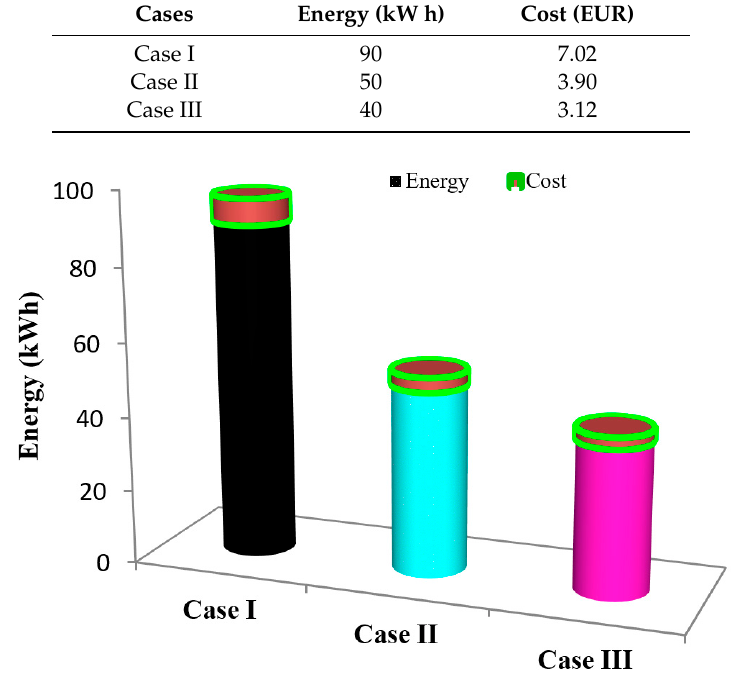
Figure 15. Comparison of average daily energy consumption and cost management for 20 users within cases I, II, and III.